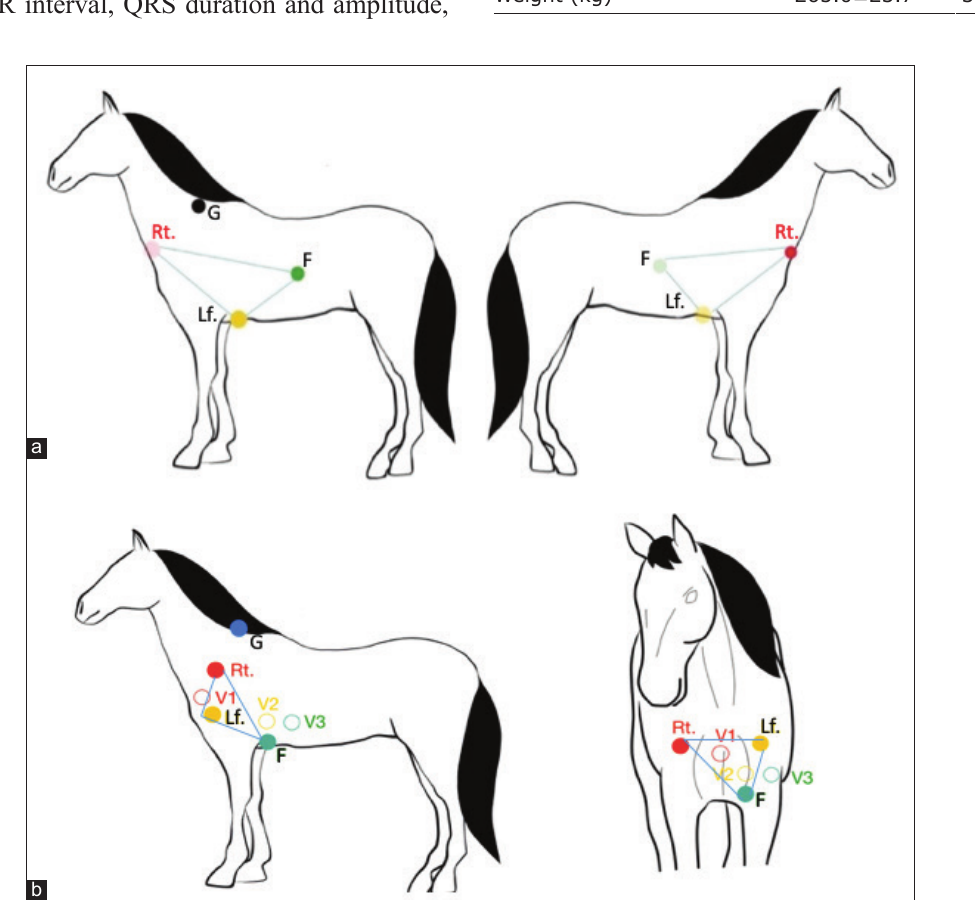
Figure-1: Two electrocardiography lead systems; base apex (a) and modified precordial leads (b), circle represented position of the electrodes; Rt, Lf, F, indicated locations of electrodes for the base apex leads and V1, V2, and V3 for the modified precordial leads, G represented ground